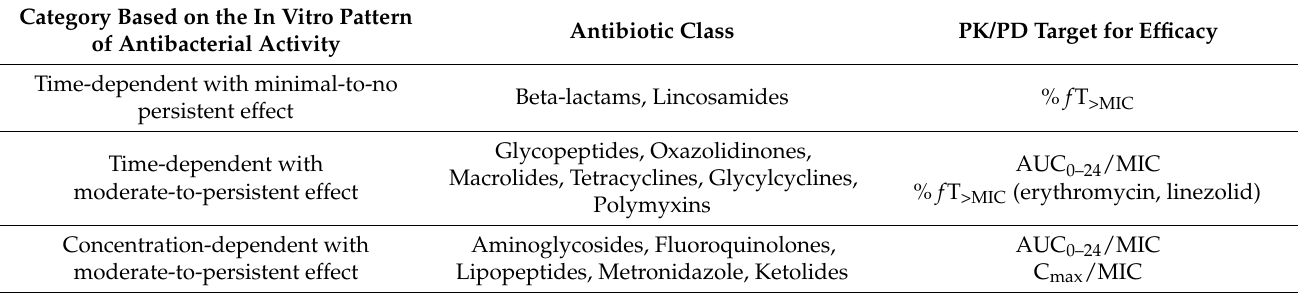
Table 2. Categories of antibiotics according to their pattern of antibacterial activity and their associated pharmacoki- netic/pharmacodynamic (PK/PD)